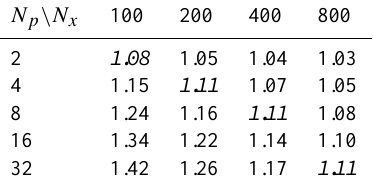
Table 1. The dependence of E [ 1 (cid:14) max i w (i) ] on N p and N x for the implicit particle filter. The number of particles N p varies along the rows and the state dimension N x along the columns. Estimates are computed from 1000 trials, and typical sampling errors are O( 0 . 01 ) . The italic values are the closest points to the dashed line in Fig. 2. N p \ N